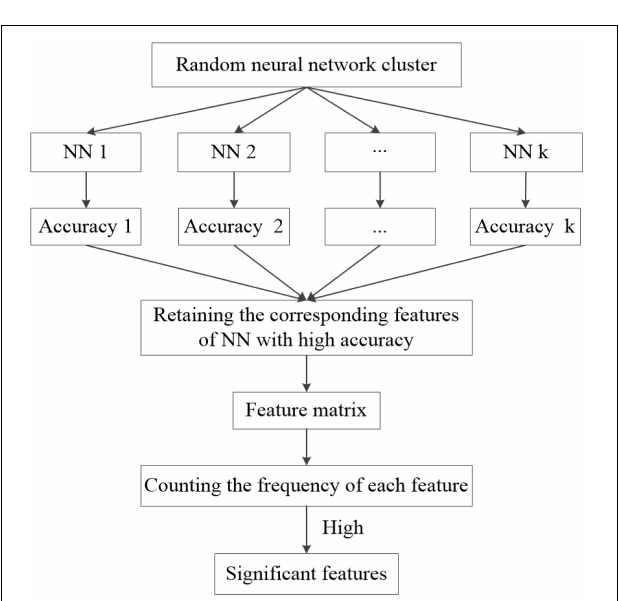
FIGURE 2 | The flow of significant feature